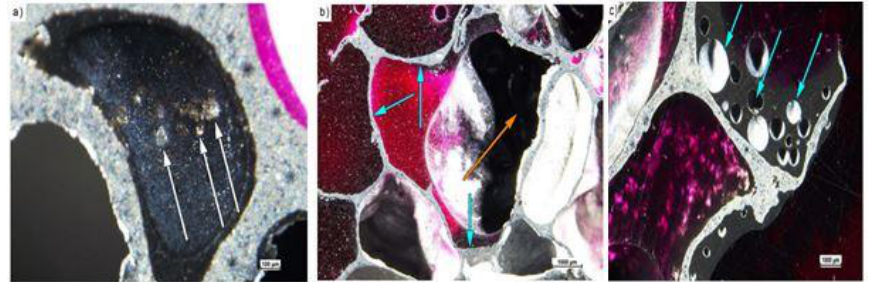
Figure 14. Defects noticed in the specimens: ( a ) adhesion issue, ( b ) partly-coated cell and ( c ) existence of bubbles (arrows shows points mentioned) [96].